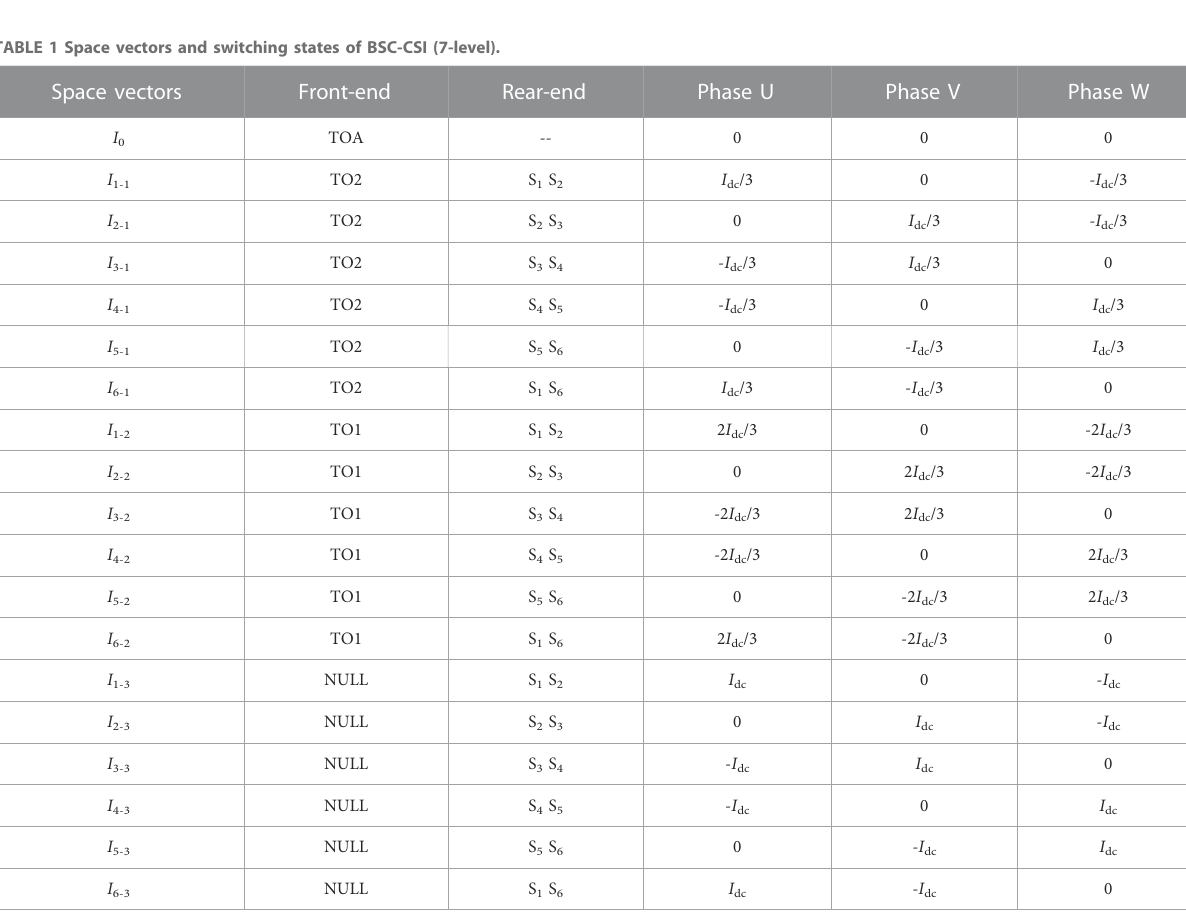
overall space vector diagram of 7-level BSC-CSI can be divided into 54 regions. As exempli fi ed in Figure 8B for Sector I, the segmented nine regions are divided by the angle bisector and the